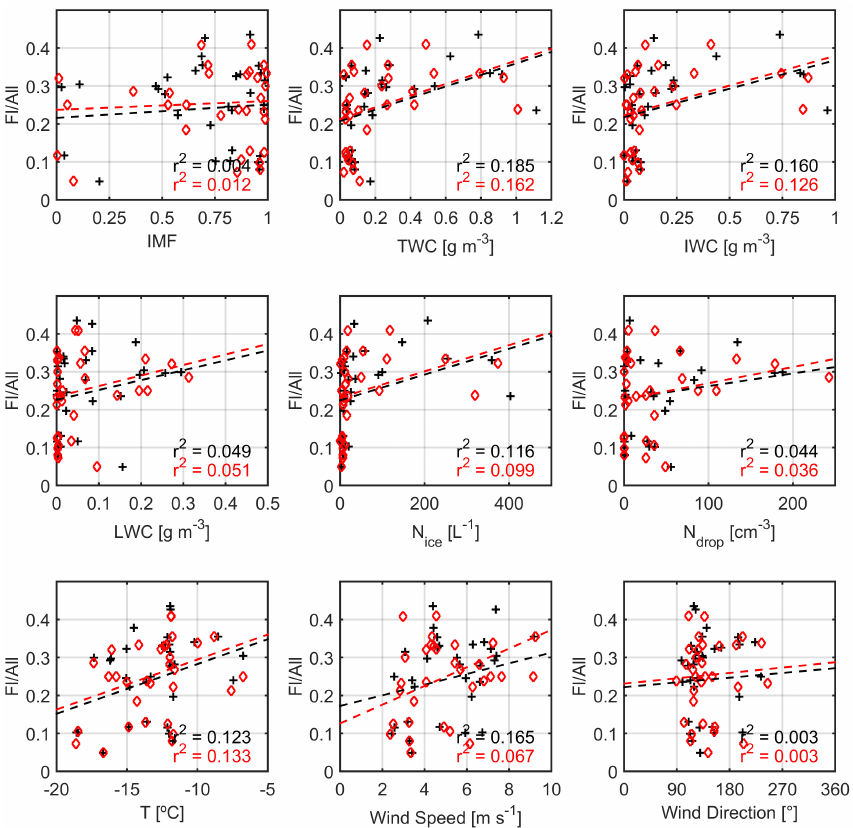
Figure 9. Correlation scatter plot of the fluorescent aerosol fraction to ice mass fraction (IMF); total water content (TWC), ice water content (IWC), liquid water content (LWC), ice crystal and droplet number concentrations, temperature, and wind speed and direction for cloud events persisting for at least 30min in duration. Mean values are denoted by black + symbols and median values by red diamonds.